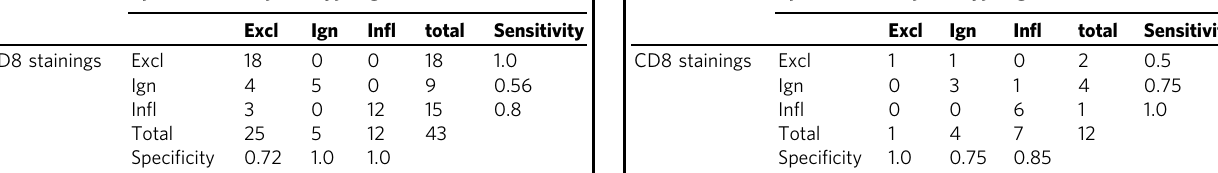
Table 1 Performance of gene classi fi er in primary TNBC. Gene classi fi er (as described in Results section and Fig. 2a) was tested for correct assignment of spatial immunophenotypes in primary TNBC (Cohort A, n =